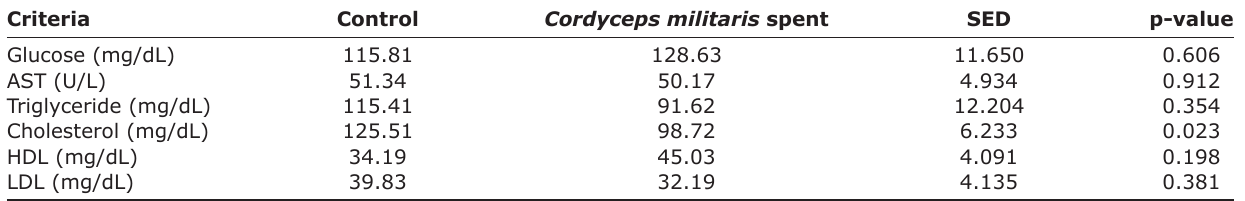
Table-5: Metabolic blood profiles in growing pigs fed Cordyceps militaris spent mushroom substrate 1 . Criteria